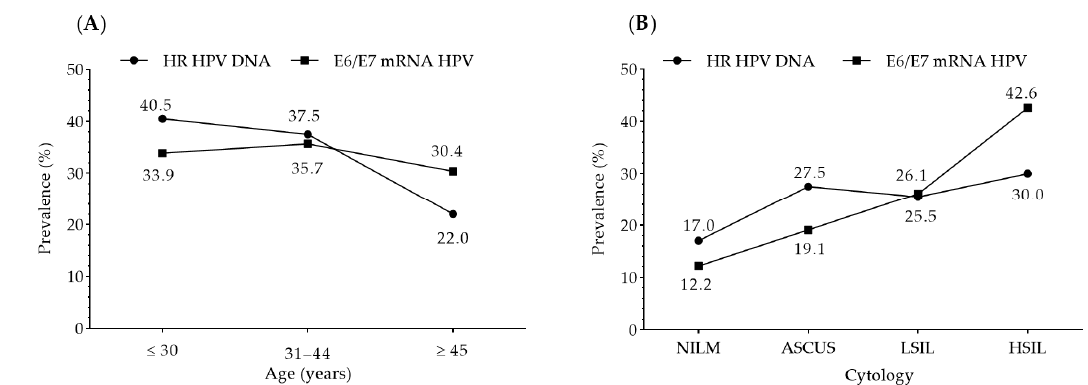
Figure 4. Prevalence of the most prevalent HR HPVs DNA and achieved oncogenic activity according to age ( A ) and cytology ( B ). NILM—negative for an intraepithelial lesion or malignancy; ASCUS—atypical squamous cells of unknown significance; LSIL—low-grade squamous intraepithelial lesions; HSIL—high ‐ grade squamous intraepithelial lesions.